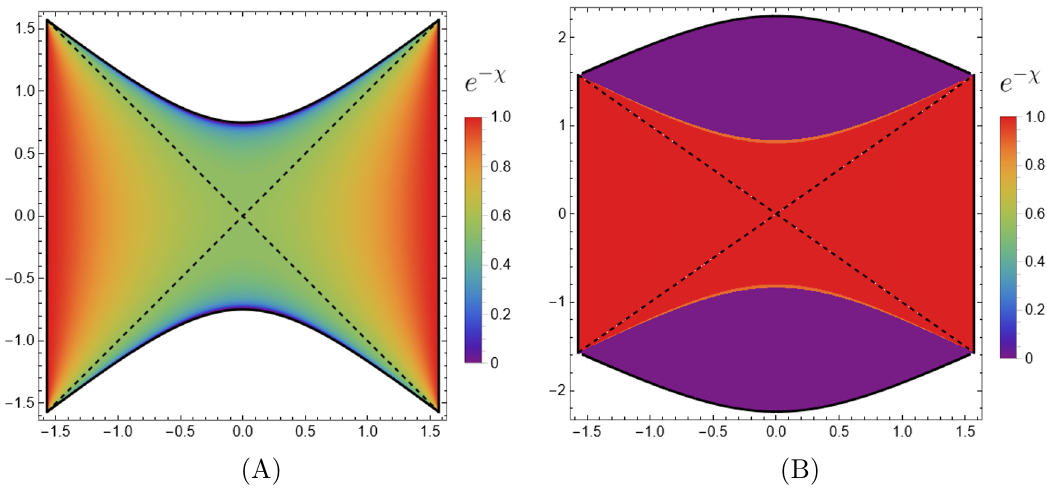
Figure 6 . Penrose diagrams for the sample solutions A and B, marked in figure 4 and whose field profiles are shown in figure 5. On the right, we see that for case B, which is close to the limit φ h → 0 , the collapse of the ER bridge is very fast, as mentioned in the main text. We refer to appendix C for the definition of the coordinates of the Penrose